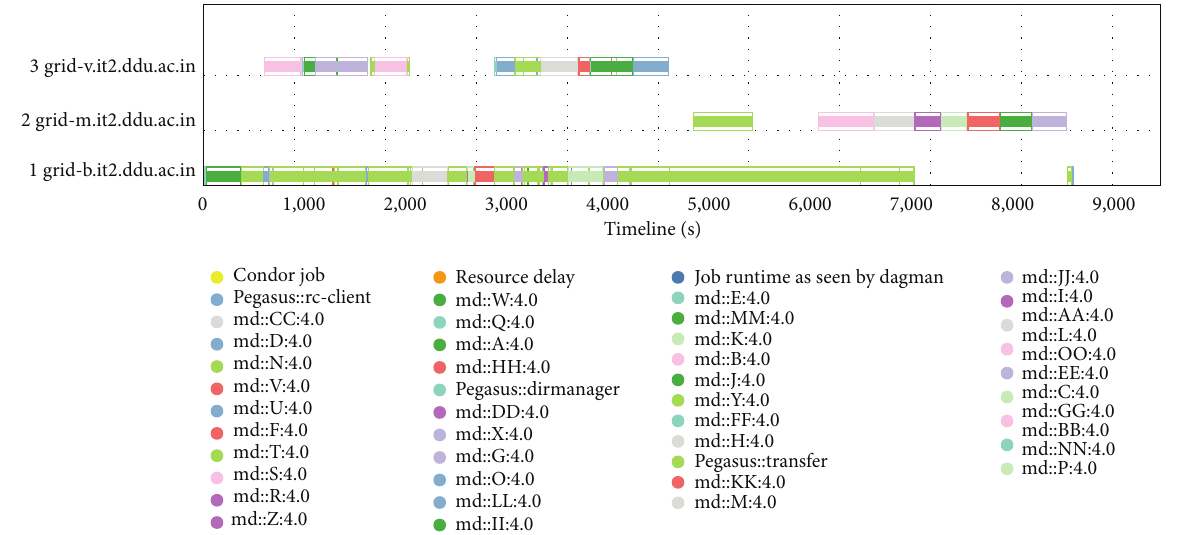
Figure 4: The output schedule for the workflow of 41 tasks with large data communication scheduled using bandwidth aware original Heft site-selector implemented by